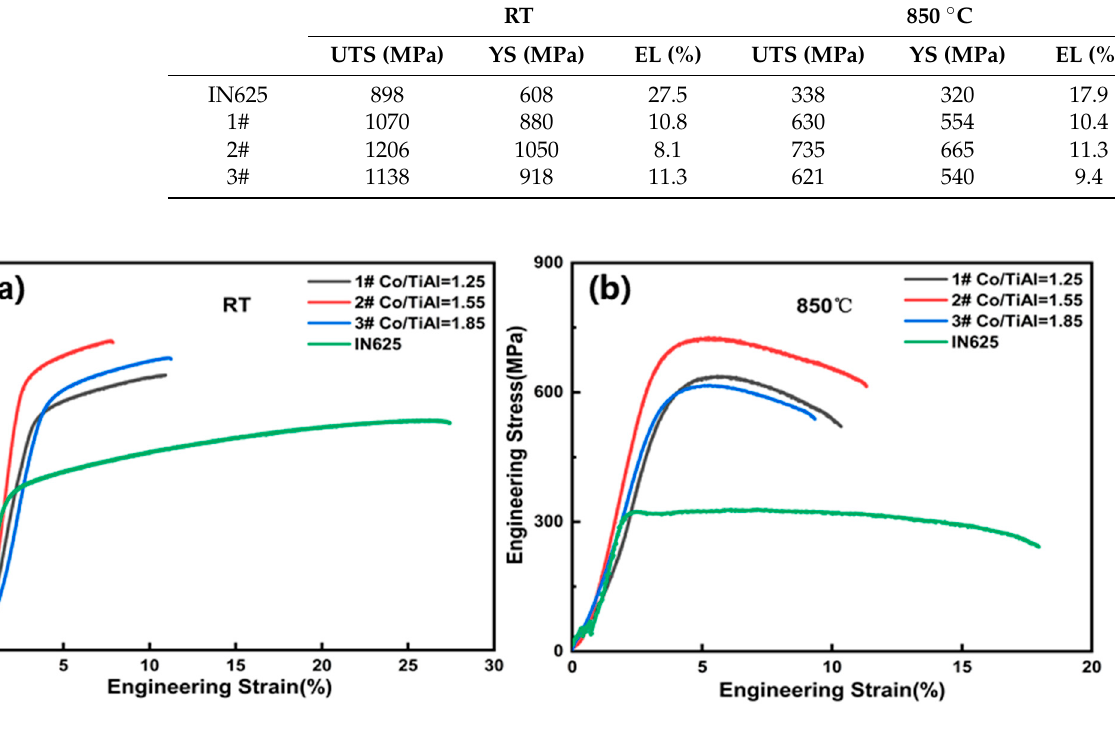
Figure 7 . Tensile curves of four coatings after heat treatment and without heat treatment (( a ) room temperature, ( b ) 850 °C).